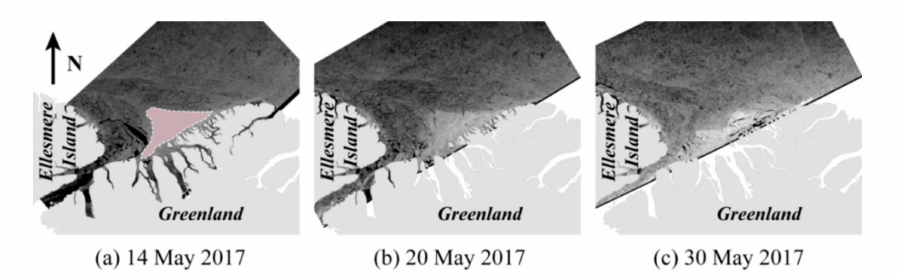
Figure 4. The process of the breakoff of the consolidated fast ice area attached to the coast of Greenland between 20 and 30 May 2017, after the collapse of the northern arch shown in the image of 14 May 2017. The red triangle marks the area of fast ice area before its